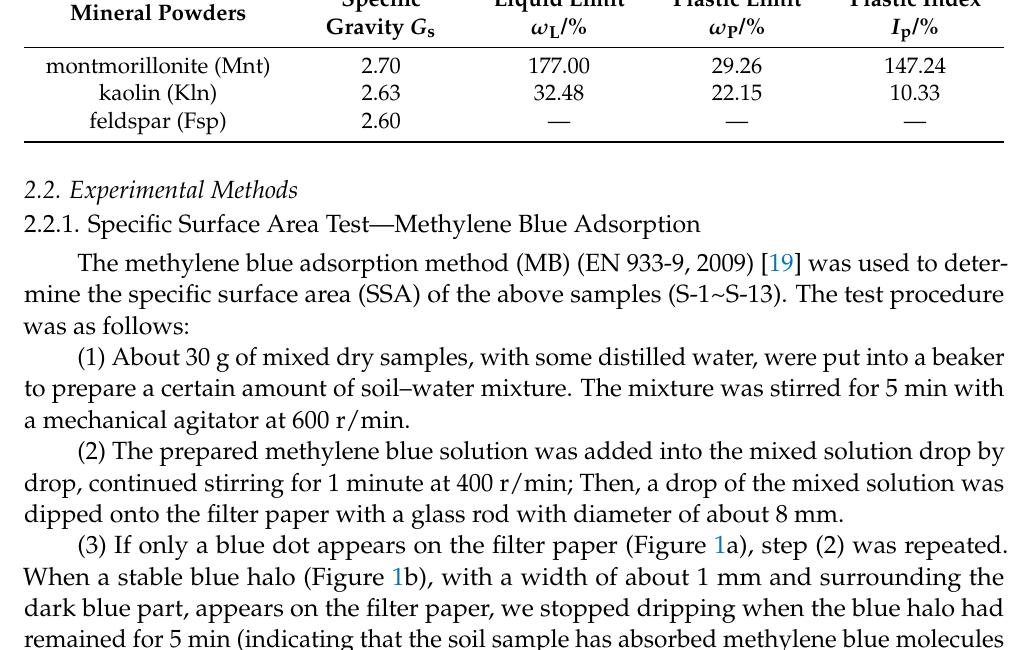
Table 1. Main physical properties of mineral powders. Mineral